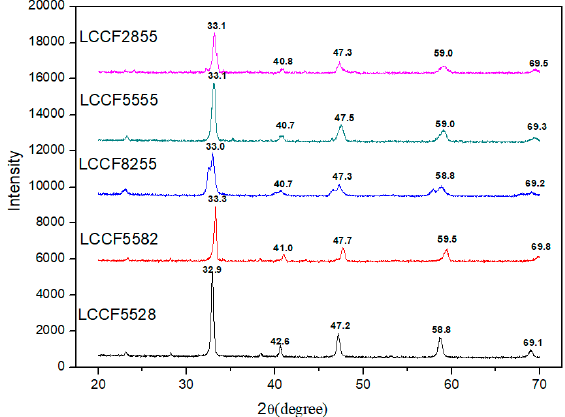
Figure 2. X-ray diffraction (XRD) patterns of fresh La 1 − x Ca x Co 1 − y Fe y O 3 − δ powders. The XRD pattern of La 0.8 Ca 0.2 Co 0.5 Fe 0.5 O 3 − δ (LCCF8255) was only slightly different from